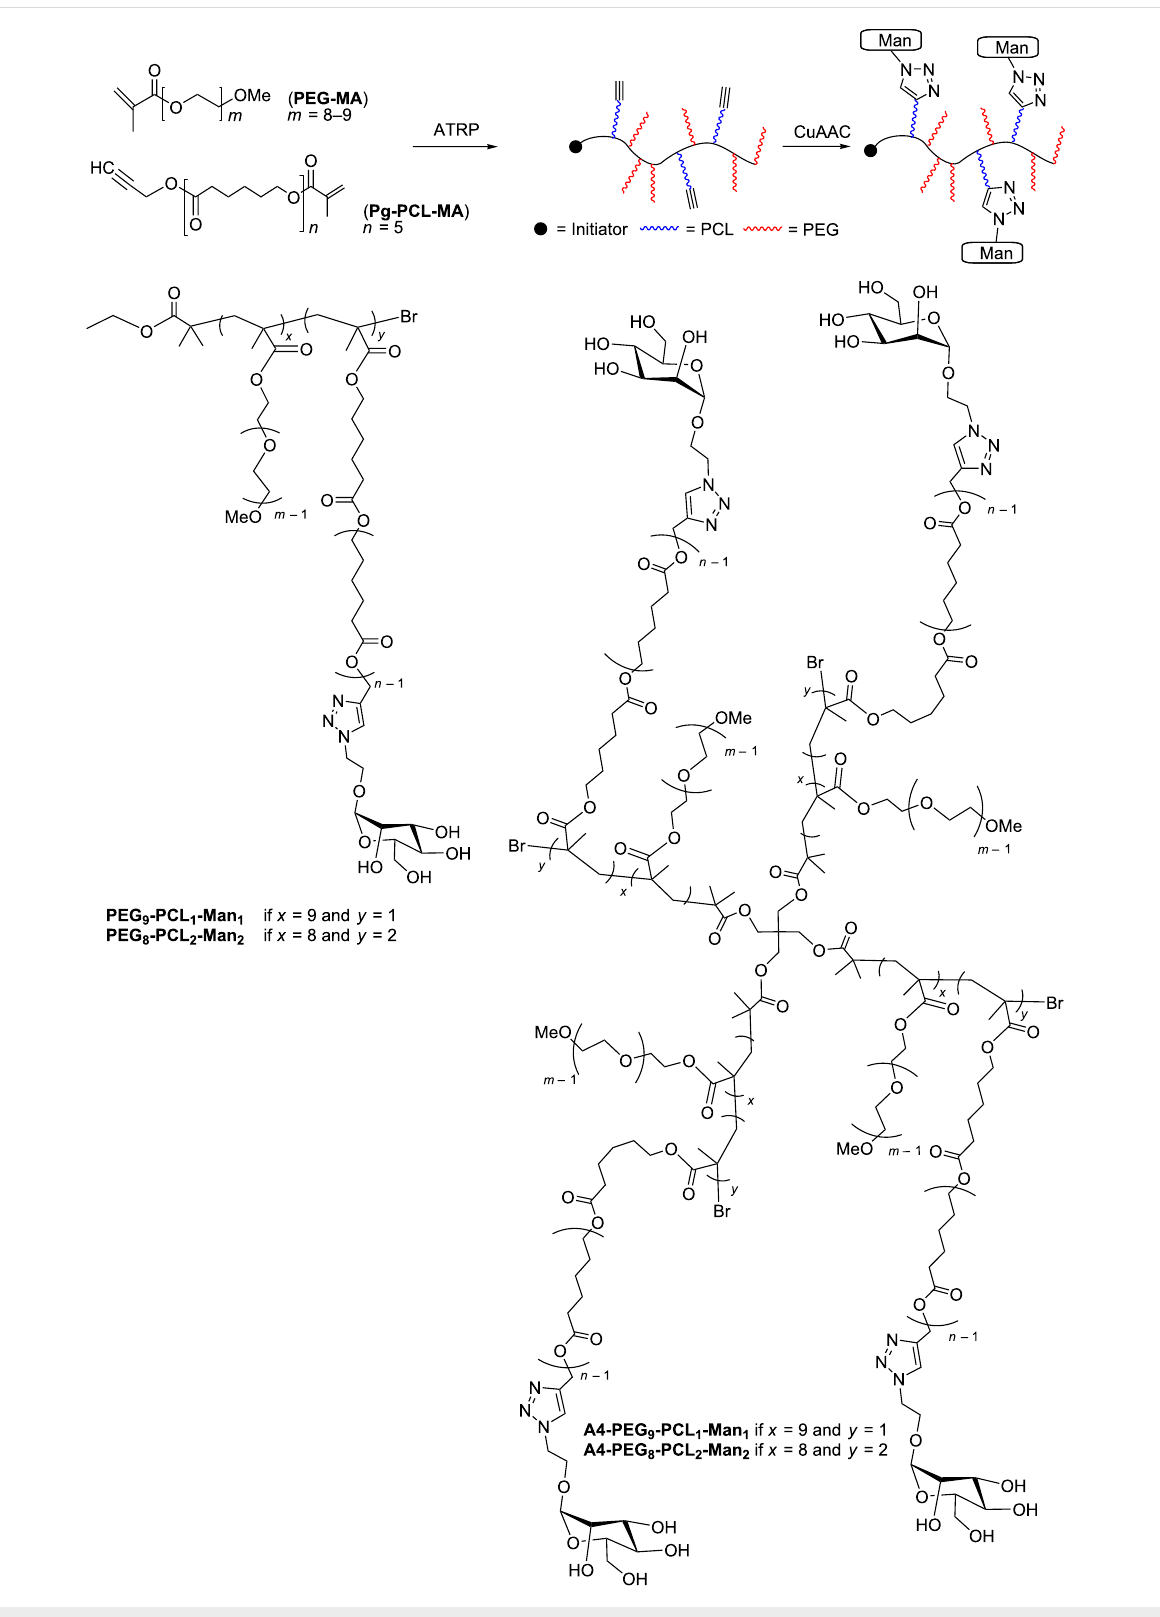
Figure 1: Synthetic approach (upper panel), final structure and nomenclature (lower panels) of the mannose-functionalized PEG-PCL